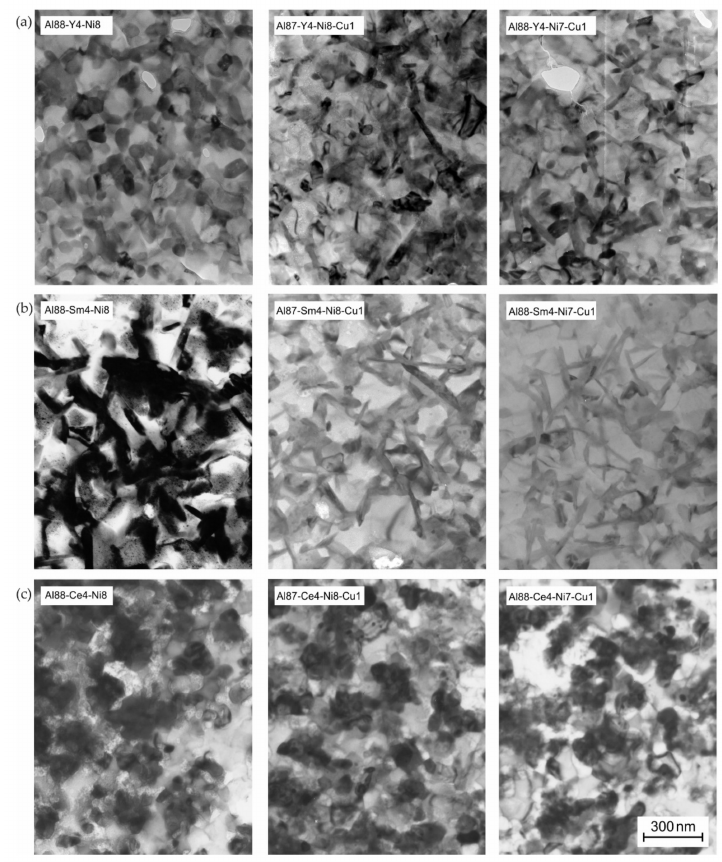
Figure 10. TEM bright field images of heat treated ribbons to the 375 ◦ C held for 30 min of ( a ) Y, ( b ) Sm, and ( c ) Ce-containing